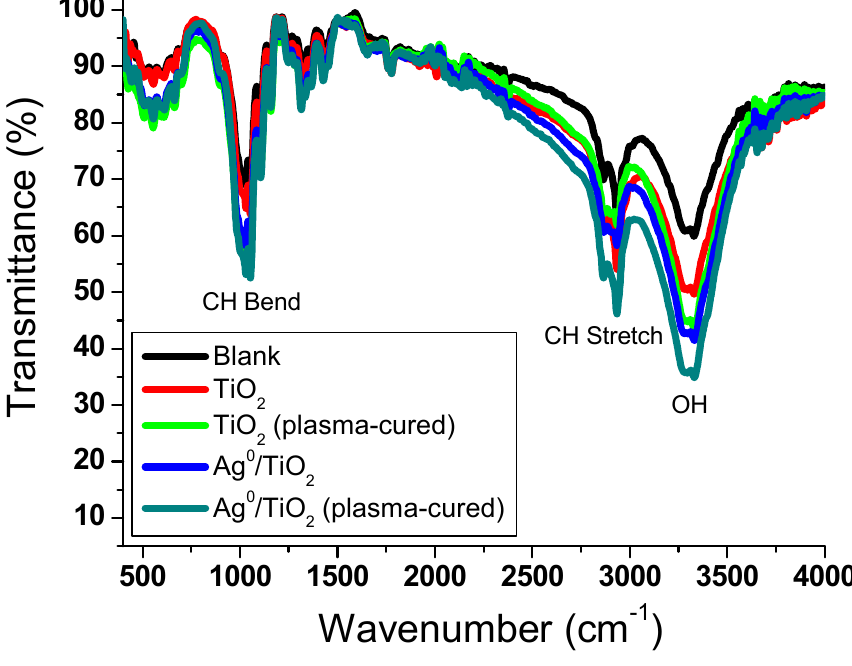
Figure 5. FT-IR spectra of coated viscose fibers.